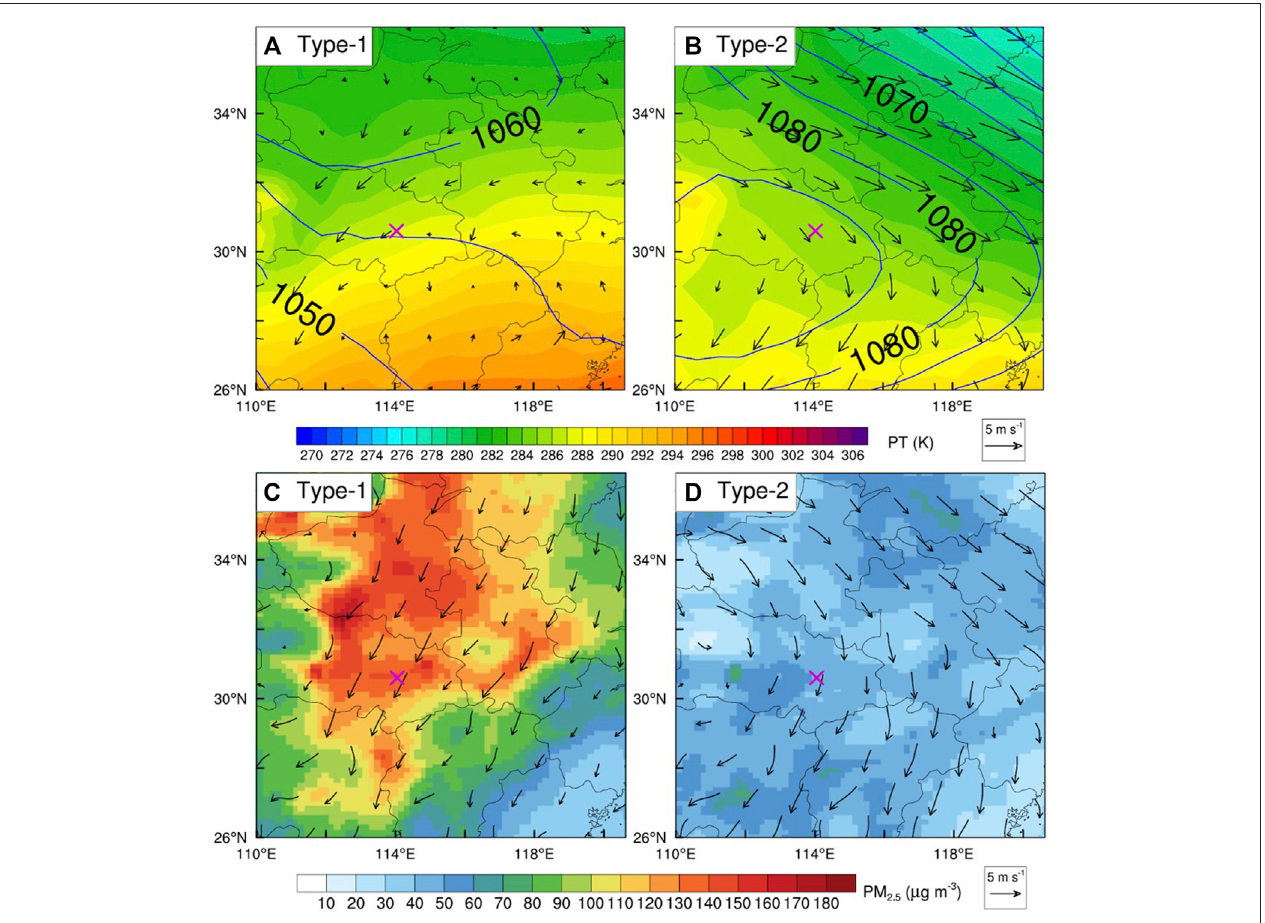
FIGURE 3 | Typical synoptic patterns associated with (A) polluted and (B) clean conditions in Wuhan, and the corresponding (C,D) near-surface PM 2.5 concentrationandwind fi elds.In (A,B) ,thesynopticpatternswereidenti fi edusingtheT-PCAonthebasisofdailyMERRA-2850-hPaPT fi elds,overlaidwithgeopotential heightandwindvector fi eldsatthe900-hPalevel.In (C,D) ,thePM 2.5 concentrationandwind fi eldswerederivedfromtheCAQRAdata,andonlythedataonthepolluted or clean days were averaged for the speci fi c type of synoptic pattern.